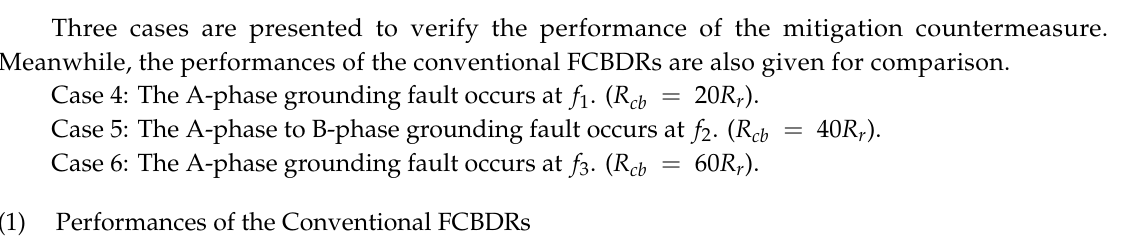
 Z in Case 3 : ( a ) w 